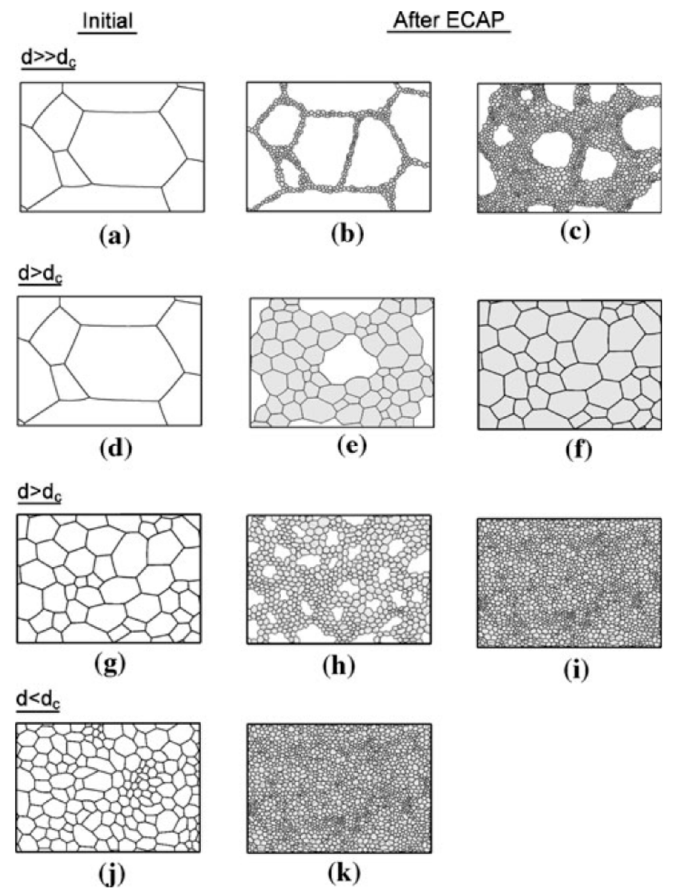
Figure 3. Illustration of the mechanism of grain re fi nement of magnesium processed via ECAP [23].